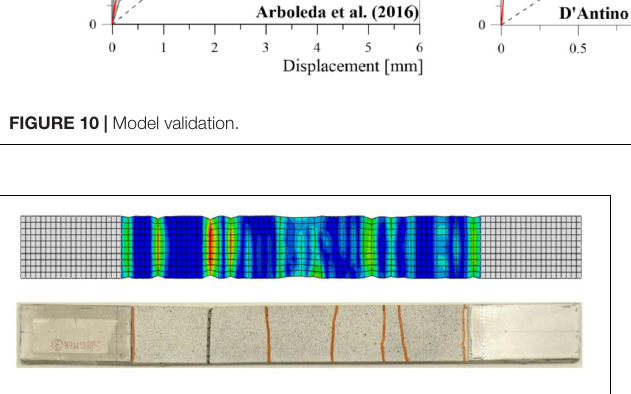
FIGURE 11 | Comparison between numerical and experimental crack pattern (Monaco et al.,